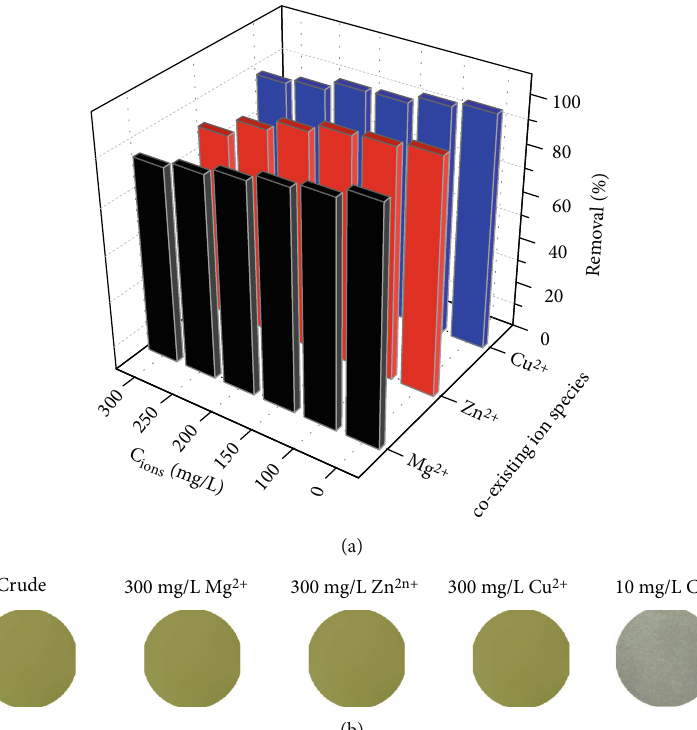
Figure 3: (a) E ff ects of coexisting ions on Ce 4+ adsorption on UA composite (initial Ce 4+ concentration 100 mg/L, adsorbent dose 0.5g/L). (b) The color of UA when it captures di ff erent metal